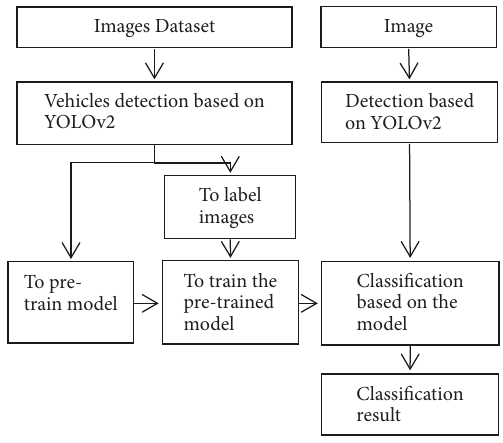
Figure 1: Flowchart of vehicle classification.